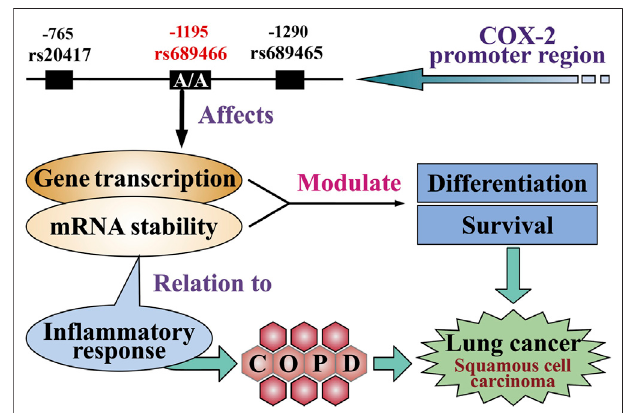
FIGURE1 | Kaplan-Meier analysis ofoverall survivalin patientswith lung squamous cell carcinoma strati fi ed by the genotype of COX-2 – 1195G/A.